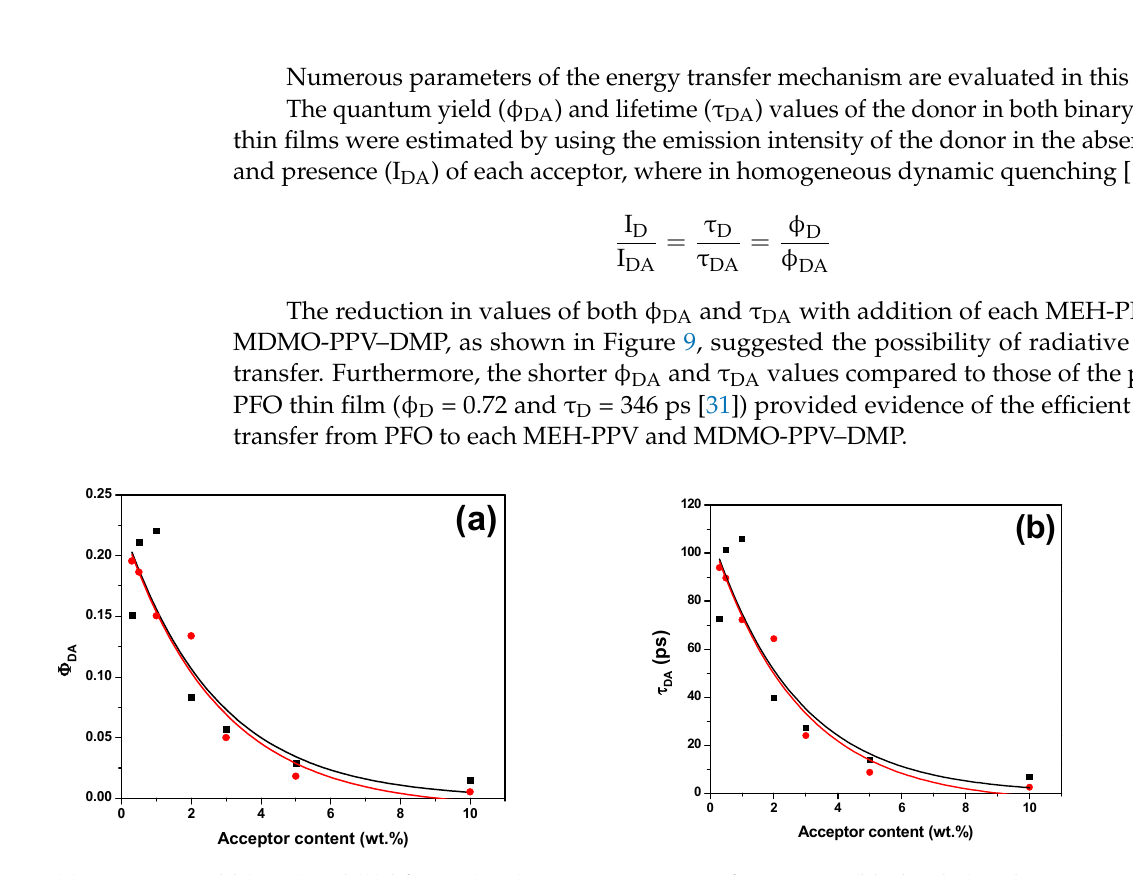
Figure 9. ( a ) Quantum yield ( Φ DA ) and ( b ) lifetime ( τ DA ) at various content of MEH-PPV (black color) and MDMO-PPV– DMP (red color). Solid curves refer to fitting data.